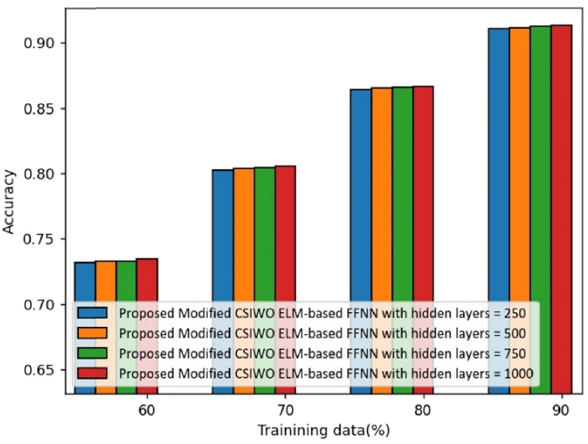
Figure 3: Analysis of developed method based on accuracy ( Switzerland dataset )